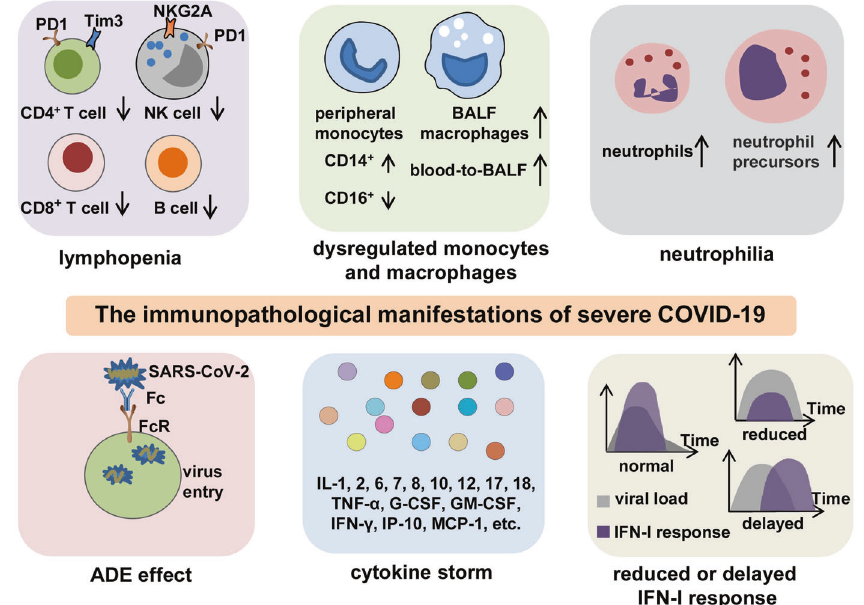
Fig. 2 The key immunopathology of severe COVID-19. The immunopathological manifestations of COVID-19 include lymphopenia, dysregulation of monocytes and macrophages, neutrophilia, ADE, reduced or delayed IFN-I response, and CS. Lymphopenia is commonly observed in severe COVID-19. In addition to decreased counts, lymphocytes often exhibit exhaustion phenotypes with the expression of higher levels of exhaustion markers PD-1, Tim-3, or NKG2A. Peripheral monocytes present a phenotype shift from CD16 + to CD14 + , and BALF macrophages are increased with a blood-to-BALF transition course. Neutrophil counts are increased with the presence of neutrophil precursors in peripheral blood, especially in patients with severe COVID-19. The possible existence of ADE enhances the entry of SARS-CoV-2 into cells through interaction between Fc regions and Fc receptors, leading to the aggravation of COVID-19. A CS is characterized by highly elevated levels of pro-in fl ammatory mediators and is a particularly central feature for poor outcomes in patients with severe or